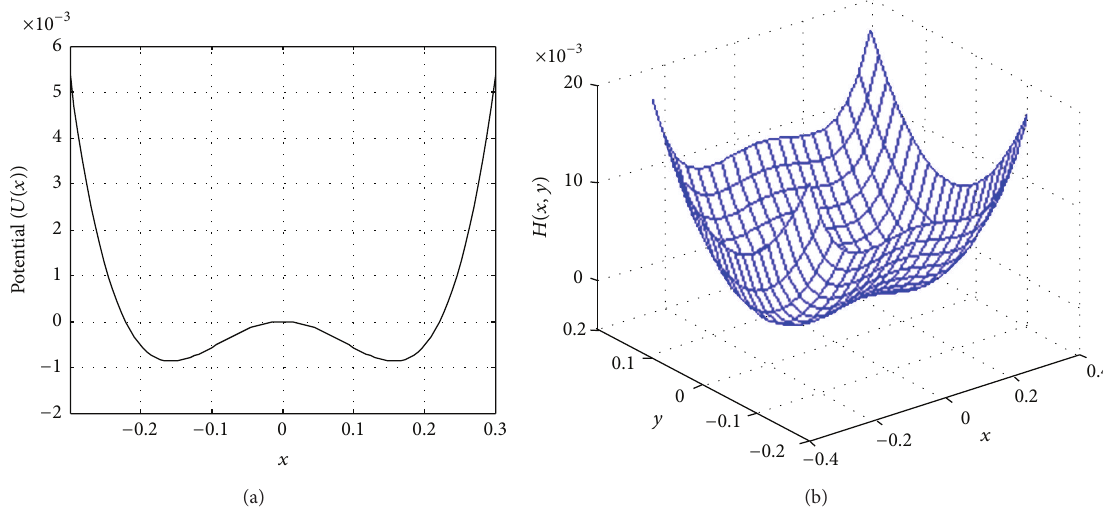
Figure 2: (a) Potential function and (b) Hamiltonian function of the unperturbed